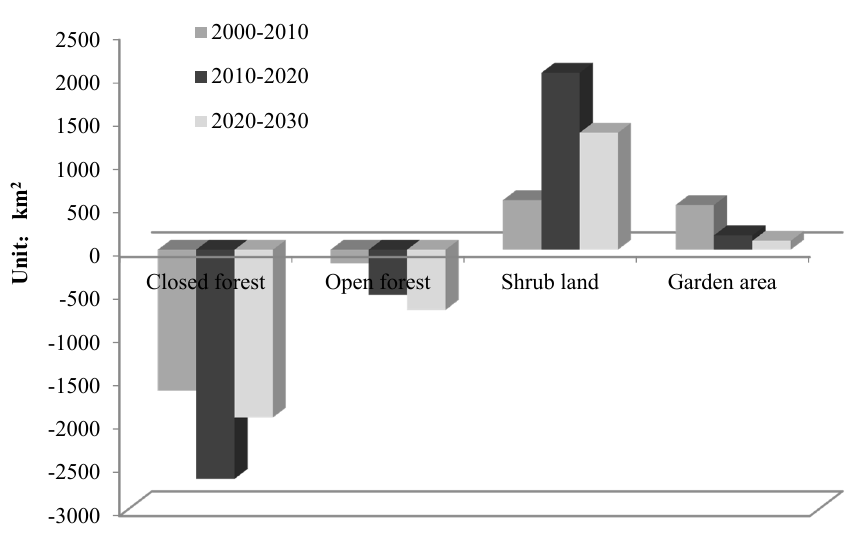
Figure 9. Forestland change under the MESSAGE climate scenario.